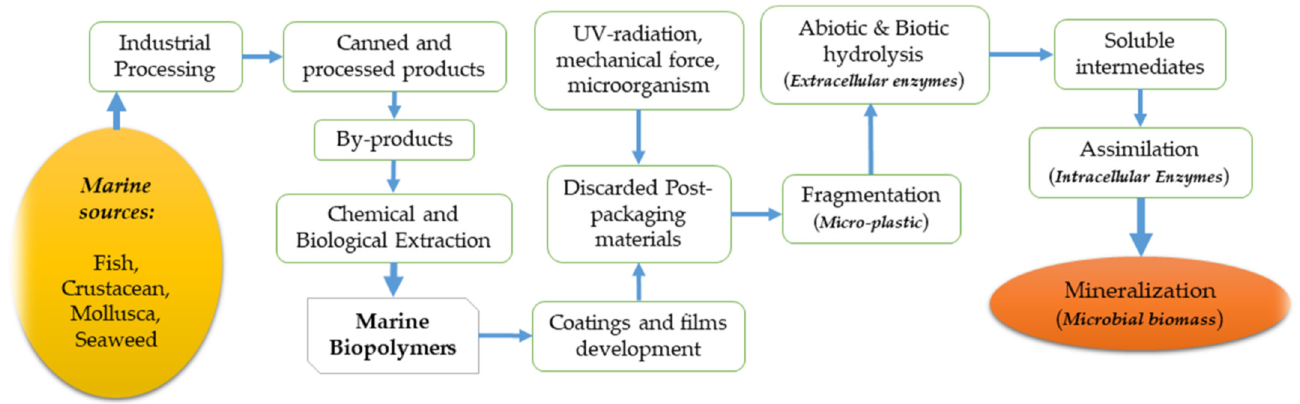
Figure 2. Schematic representation of the complete cycle of marine biopolymers—from production through to the biode- grading of the environment.